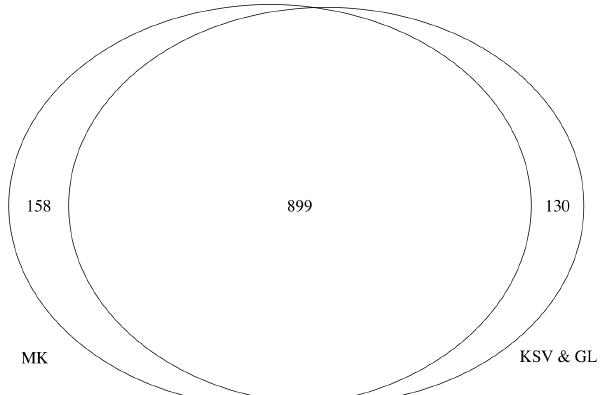
Figure 3. Venn diagram with the number of mapped landslides in the randomly selected tiles by the two initial experts and qual- ity control (MK, KSV & GL: 899), the number of landslides only mapped by the quality control (MK: 158) and the number of land- slides mapped only by the two initial experts (KSV & GL: